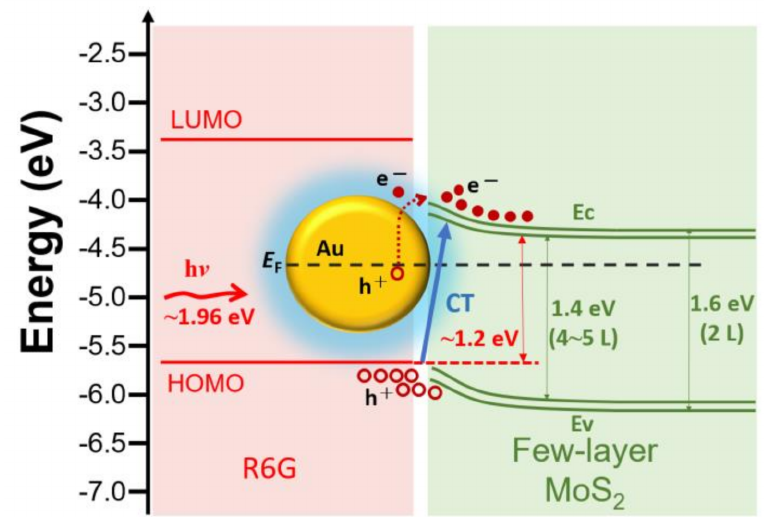
Figure 6. Schematic diagram of hybrid effects of both EM and CM between R6G molecules and few-layer MoS 2 decorated with Au NPs on Si